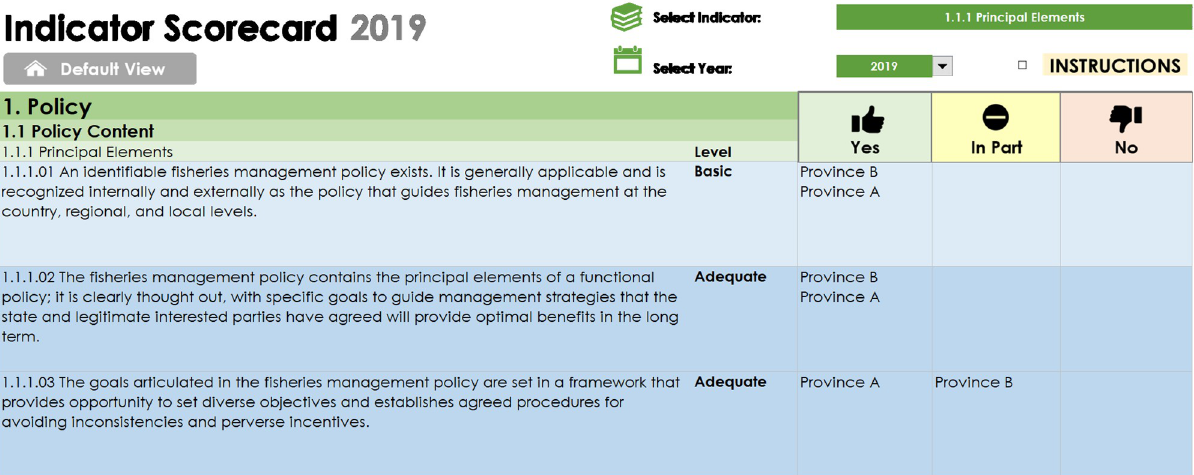
Fig 6. Reviewing results at a high level provides a general overview of progress, or lack thereof. The indicator scorecard enables the user to select a performance area of interest and compare where multiple jurisdictions have been assessed. This detailed look across indicators focuses the output on deficiencies in performance and reveals gaps where additional information may be needed to better inform the